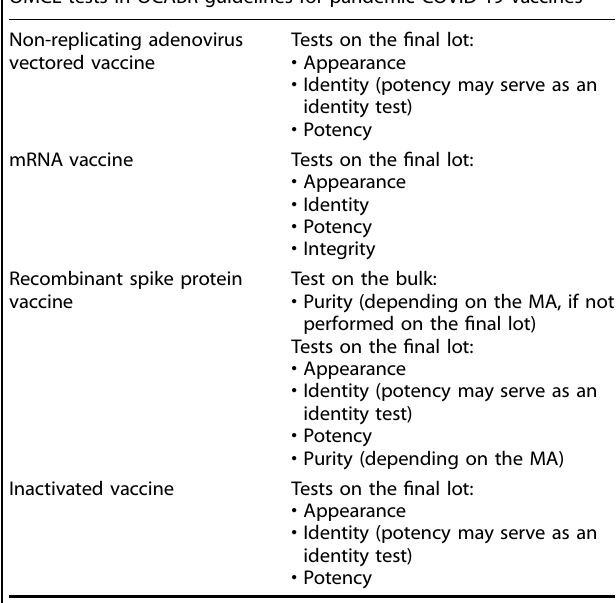
Table 2. List of tests to be carried out by OMCLs as described in section 2 of OCABR guidelines for COVID-19 Vaccines*. OMCL tests in OCABR guidelines for pandemic COVID-19 vaccines Non-replicating adenovirus vectored